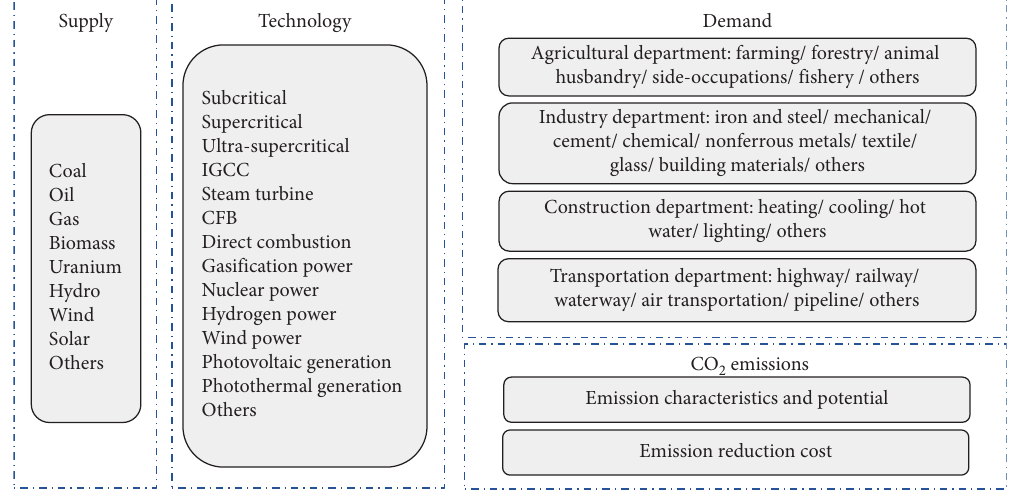
Figure 1: TIMES model of CO 2 emission reduction in China’s power